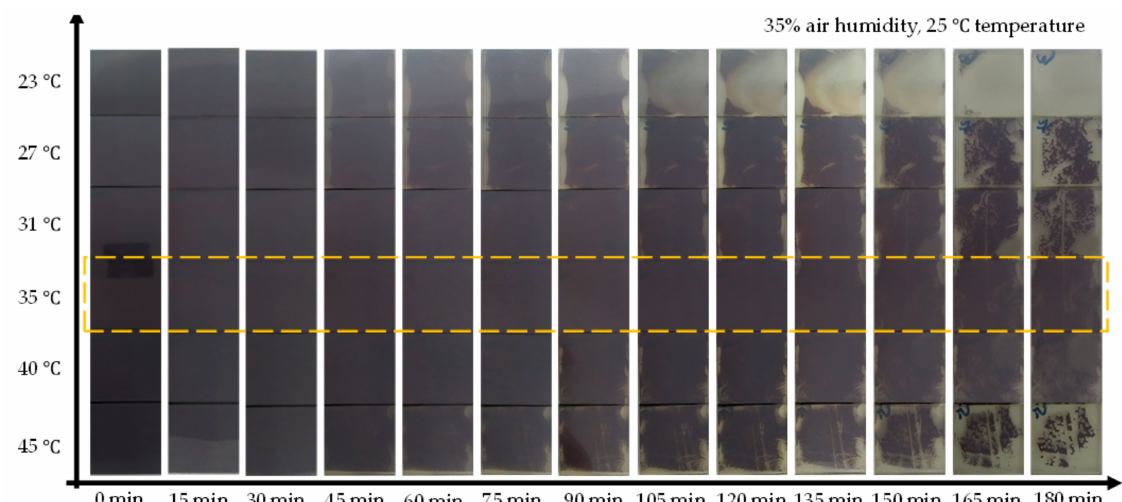
Figure 4. The morphology photos of CsPbI 2 Br perovskite thin films aged 180 min in air atmosphere with relative humidity (R.H.) of